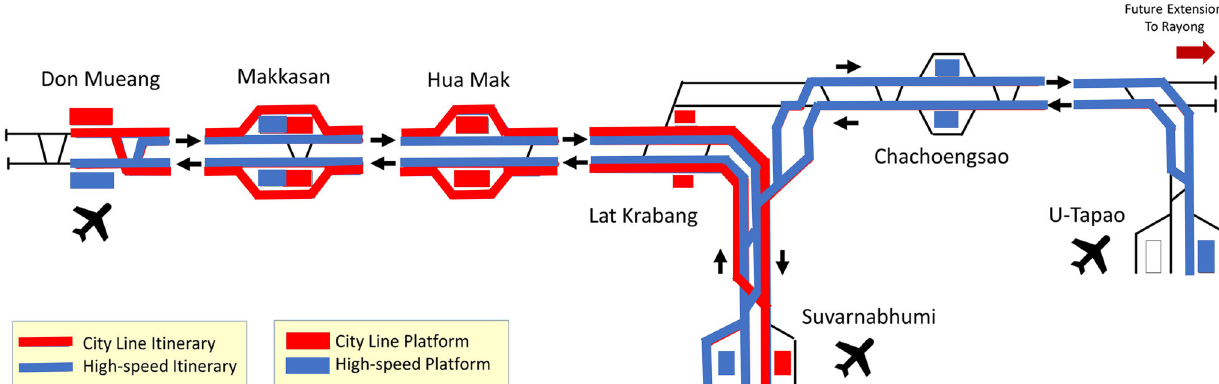
Fig. 3 Trip itinerary for city line and high-speed Fig. 2. With the mixed service pattern and train configu- rations, it is a challenge to plan for the timetable, especially for the in-town section between SVB and DOM. There are two stations where the faster train can pass over, but this pass over needs to be planned properly, so that it does not